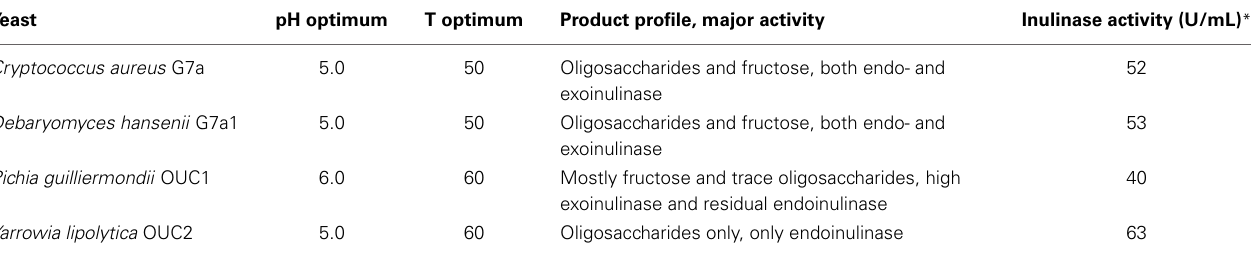
Table 5 | Catalytic behavior of inulinases from marine yeasts (Gao et al.,